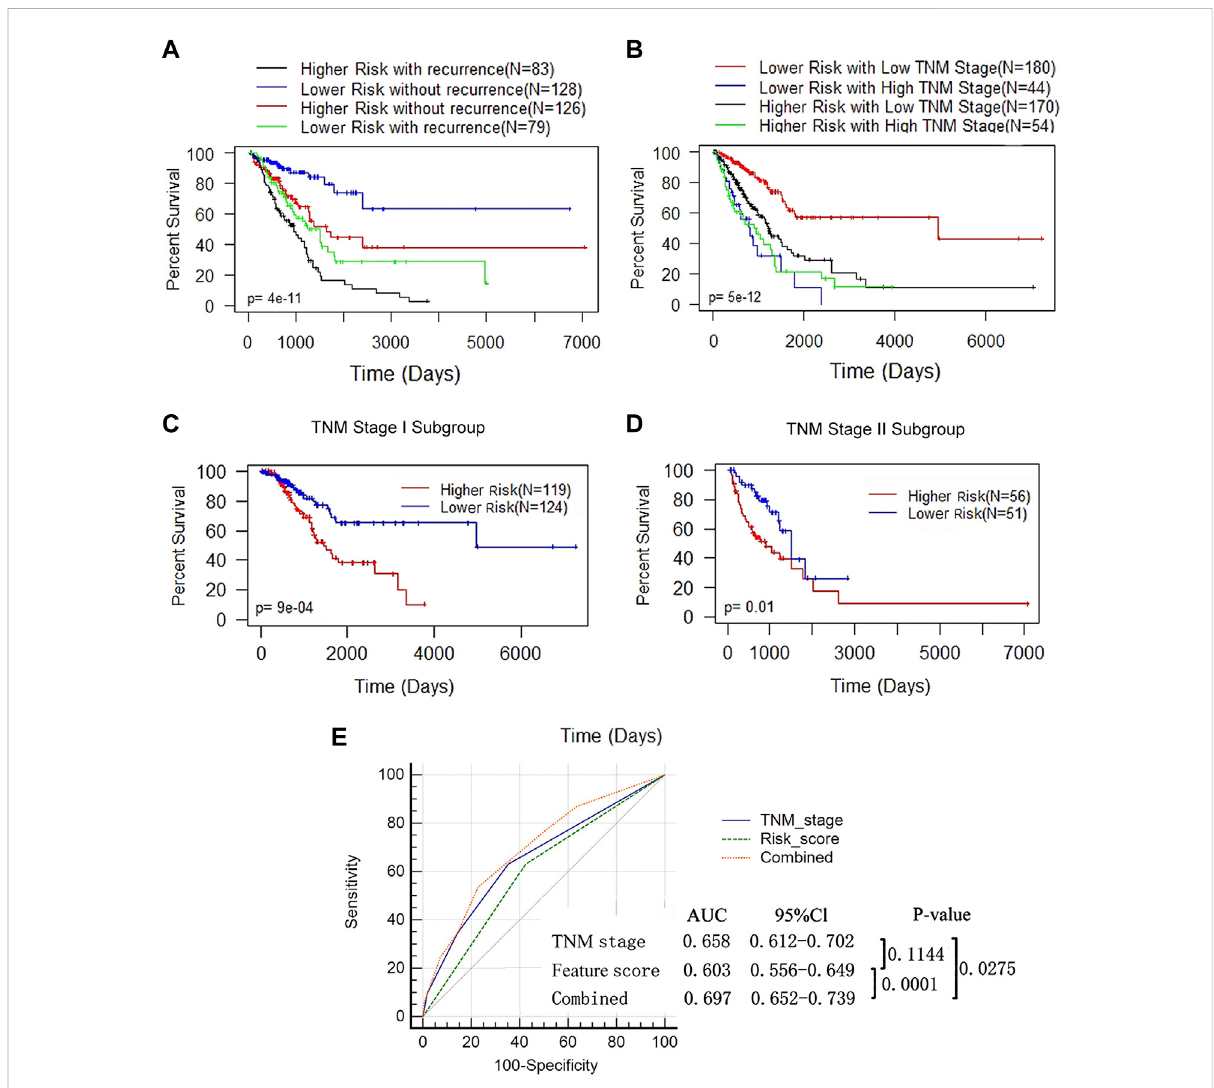
FIGURE 6 TheprognosticvalueofDNAmethylationfeaturescorewasnotassociatedwithtumorrecurrencestatusandTNMstage. (A) K-Manalysis ofOS based on the DNA methylation feature and recurrence status. The LUAD patients were divided into the lower- and higher-risk subgroups according to the median of the methylation feature scores, with or without recurrence. Log-rank test ( p < 0.0001). (B) K-M analysis of OS based on the DNA methylation feature and TNM stage. The LUAD patients were dividedinto the lower- and higher-risk subgroups according to the median of the methylation feature scores, and divided into the low (stage I+ II,n = 350) and high (stage III+IV, n = 98) stagesaccording to theTNM stage (Log-rank test, p < 0.0001). (C) K-Mcurves forpatientsintheTNMstageIsubgroup( n =350). (D) K-Mcurves forpatientsintheTNMstageIIsubgroup( n =98). (E) ROC analysis assessed the sensitivity and speci fi city of DNA methylation feature score, TNM stage and the combination of the 2 factors in predicting